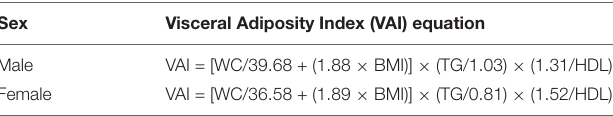
TABLE 1 | Sex-specific equations for calculation of the visceral adiposity